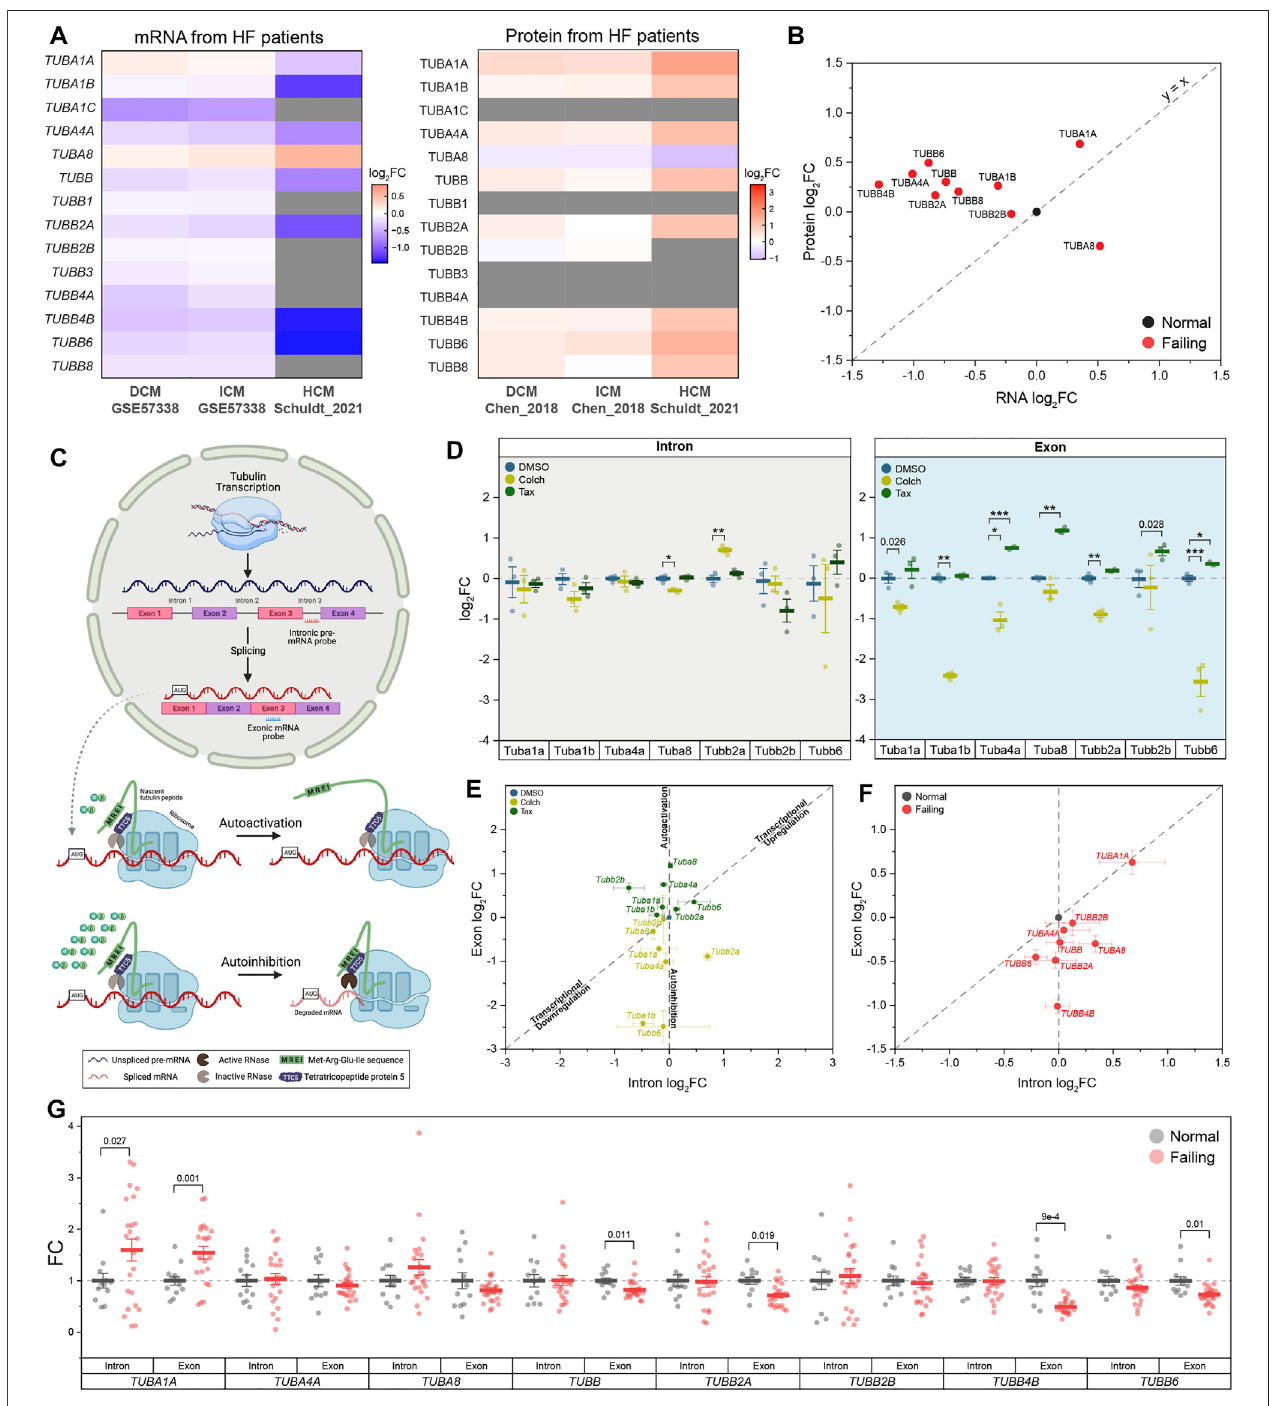
FIGURE 1 | Tubulin autoregulation is operant in the heart and activated in heart failure. (A) Heatmaps of previously published mRNA (left) & protein (right) data of human αβ -tubulin isoforms during dilated (DCM) (Liu et al., 2015, Chen et al., 2018), ischemic (ICM) (Liu et al., 2015, Chen et al., 2018), & hypertrophic (HCM) (Schuldt etal.,2021)cardiomyopathies. (B) Scatter-plotoflog 2 fold-changeofmRNAonx-axisandlog 2 fold-changeofproteinony-axisinheartfailure;eachdatapointrepresents anaveragelog 2 fold-changevaluefromDCMandICMgroupsfrom (A) ,andy=xrepresentsaproportionatechangebetweenmRNAandpeptide. (C) Schematicof tubulin autoregulation: The introns of tubulin pre-mRNA are spliced out and the mRNA is fully translated in the absence of excess free tubulin; in the presence of excess freetubulin,themRNA,butnotthepre-mRNA,isdegraded. (D) Relativelog 2 fold-changeofmRNAcountsofintronic(left)andexonic(right) αβ -tubulinisoformsinisolated adult mouse cardiomyocytes after treatment with either depolymerizing (Colch) or polymerizing (Tax) agents ( n = 3); whiskers represent ± 1SEM, bolded line represents mean, * represents p-value from Welch-corrected two-tailed two-sample t-test on non-log data < 0.025 (Bonferroni-corrected for two comparisons), ** represents